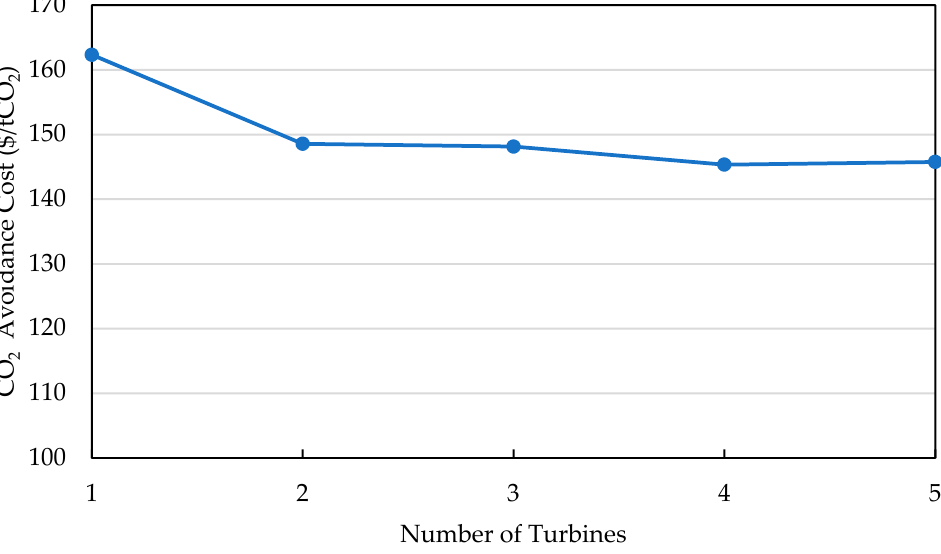
Figure 12. CO ₂ avoidance cost of a 10% bio-SNG co-fired power plant with CCS. An NGCC power plant without CCS was used as the reference case for the CAC calculations. One turbine corresponds to approximately 254 net MW of power.